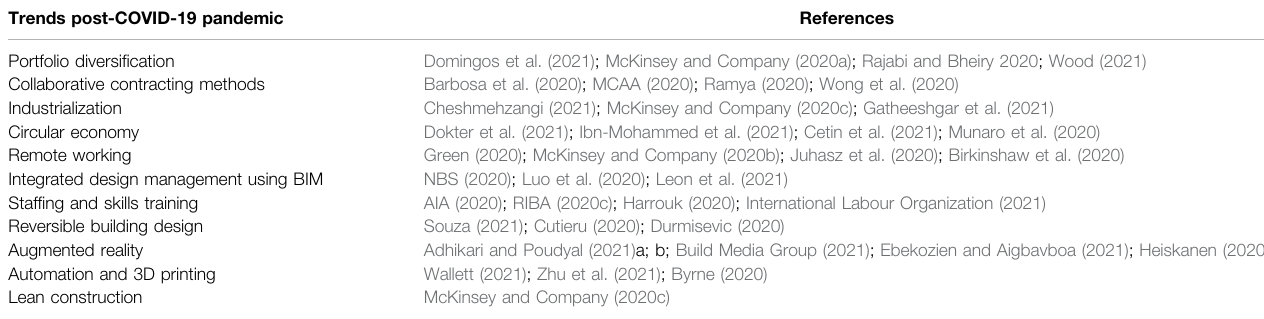
TABLE 1 | Eleven major trends for the future of the AEC industry